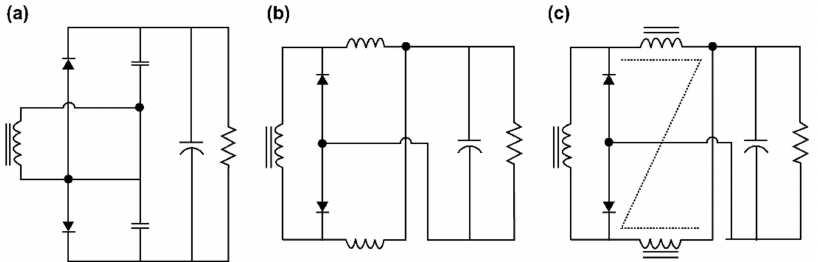
Figure 4. Development of the proposed CICDR: ( a ) voltage-doubler rectifier; ( b ) current-doubler rectifier; ( c ) electrical schematic of the proposed CICDR.